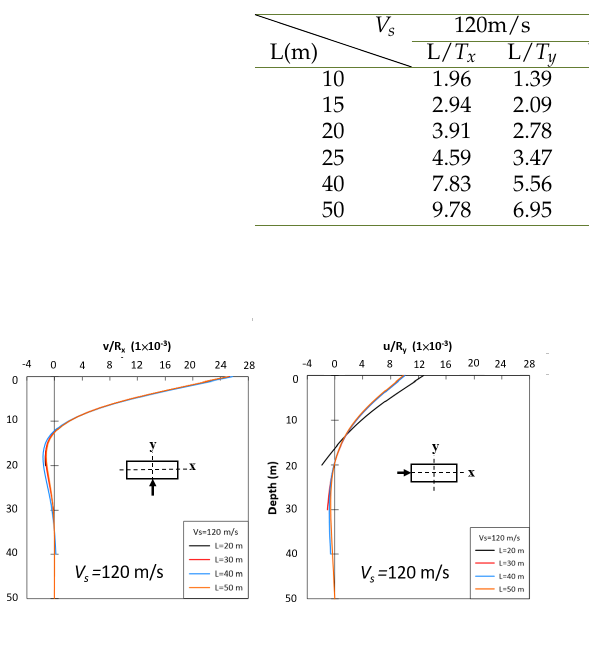
Table 4. Normalized length of barrettes